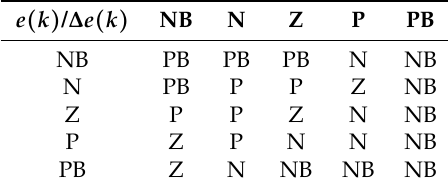
Table 2. Fuzzy rules for K i gain [30].